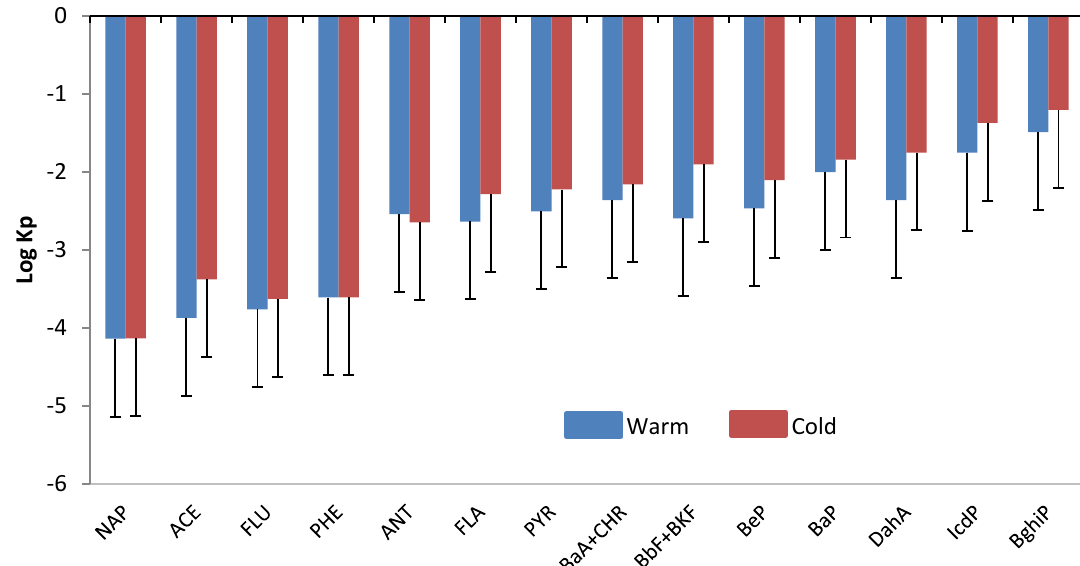
Figure 5. Comparison of the warm and cold seasons with the log Kp of the 16 PAHs. Error bars represent the standard deviation of the mean compound value for all samples in each period.